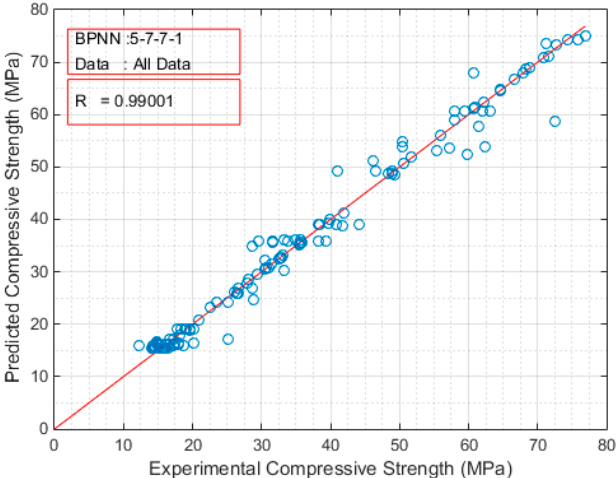
Figure 6. The Pearson’s correlation coefficient R of the experimental and predicted compressive strength for the best with two hidden layers BPNN (5-7-7-1).